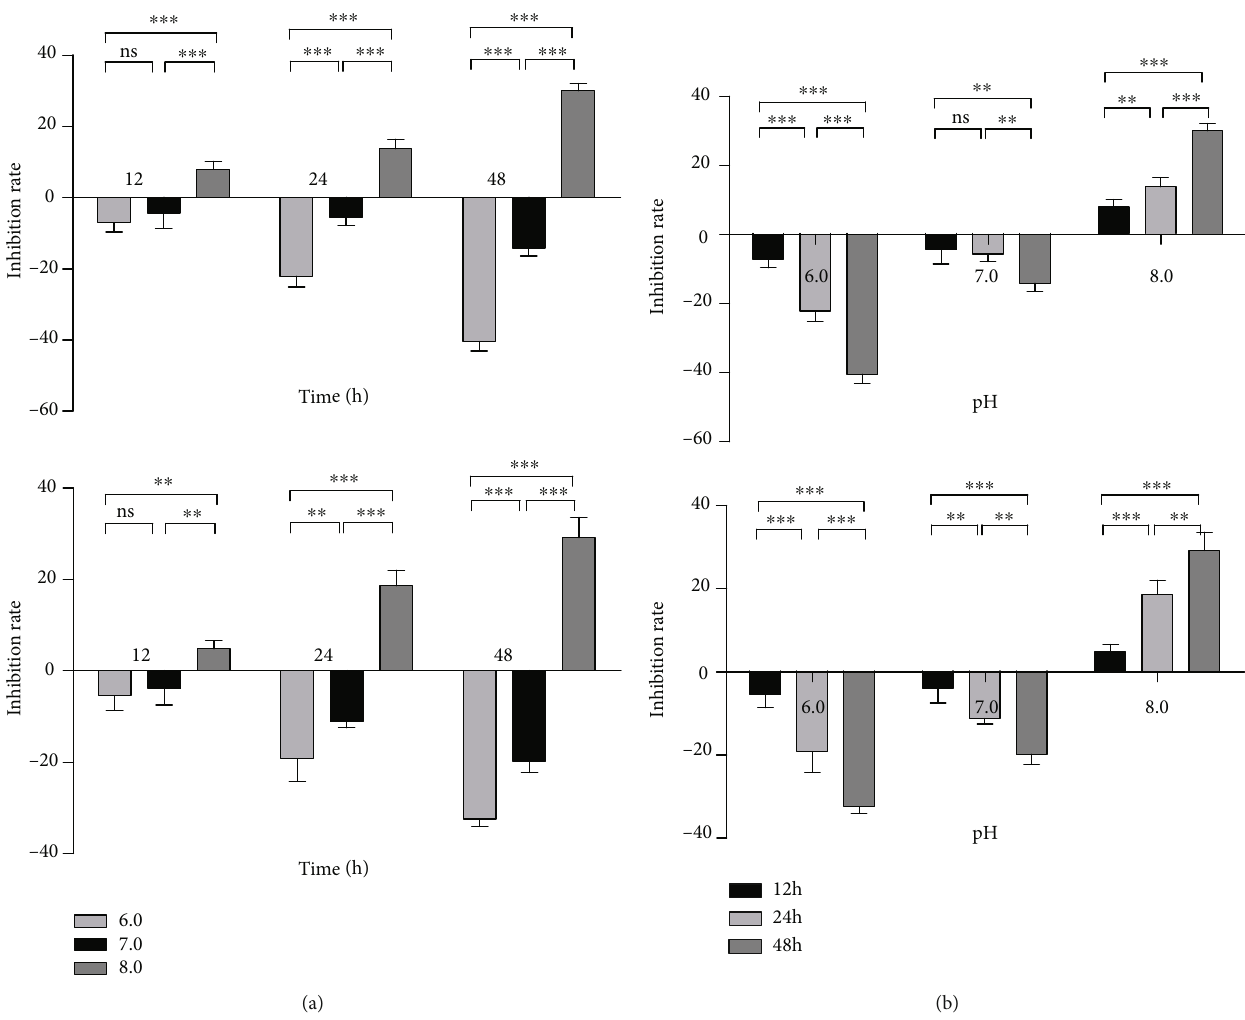
Figure 1: Alkaline microenvironment inhibited the viability of GC cells. Compared with the blank control group, the optical density (OD) value increased in the pH 6.0 or pH 7.0 group, and the inhibition rate was negative, indicating cell promotion. When the OD value of the pH 8.0 group was lower than that of the blank group, the inhibition rate was positive, indicating cells inhibition. When pH 6.0 or pH 7.0, the viability of GC cells was promoted. The smaller the pH value was, the smaller the inhibition rate of cells was, and the greater the viability of cells was. However, in the pH 8.0 group, the viability of GC cells was inhibited, showing that the alkaline environment inhibited the viability of GC cells (b). (a) Viability analysis of GC cells (SGC-7901 and MKN45) treated with di ff erent culture times (12 h, 24h, and 48h). (b) Viability analysis of GC cells (SGC-7901 and MKN45) treated with culture media of di ff erent pH values (pH6.0, pH 7.0, and